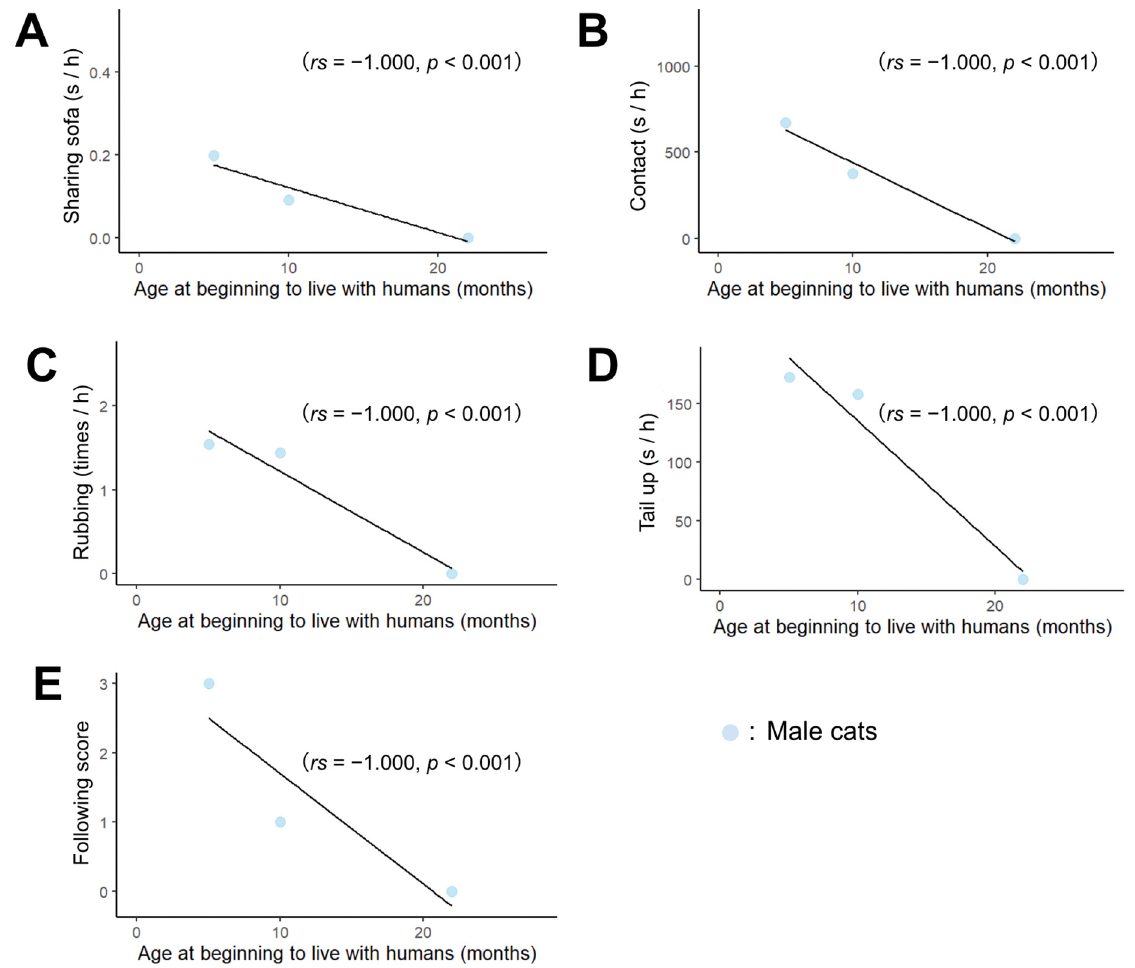
Figure 2. Correlation between behavior towards experimenters and age at keeping with humans (months). ( A – E ) indicate the relationship between age at beginning to live with humans and the following behaviors, ( A ) Sharing sofa, ( B ) Contact, ( C ) Rubbing, ( D ) Tail up, ( E ) Following.